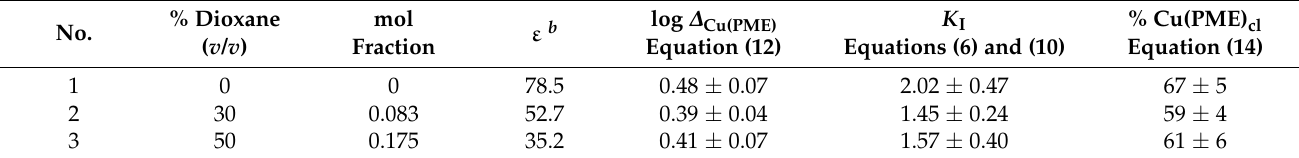
Table 9. Extent of chelate formation according to Equilibrium (5) in the Cu(PME) species as quanti- fied by the dimension-less equilibrium constant K I (Equations (6) and (10)) and the percentage of Cu(PME) cl (Equation (14)) in aqueous solution and in water containing 30 or 50% ( v / v ) 1,4-dioxane together with properties of the mentioned solvents (25 ◦ C; I = 0.1 M, NaNO 3 ) a